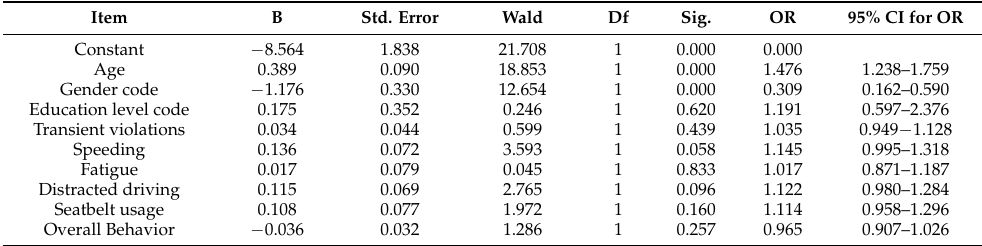
Table 8. Causal relationship between psychosocial-behavioral parameters and number of faults when involved in an